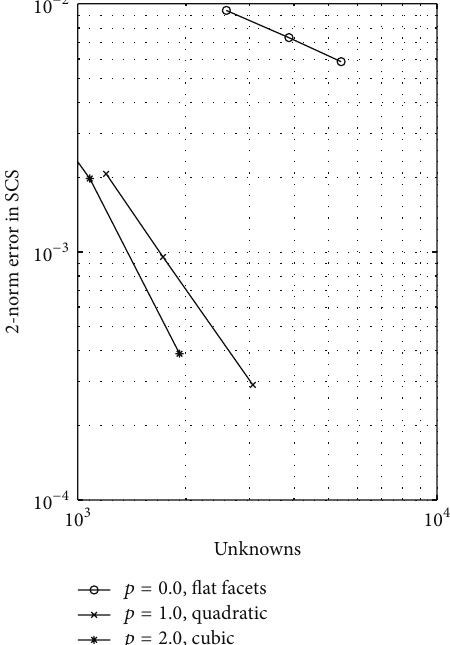
Figure 5: Error in the SCS versus the average edge lengths in the models, for a sphere with 𝑘𝑎 = 2𝜋 . EFIE results are reported for flat-faceted models used in conjunction with 𝑝 = 0.5 basis and test functions, quadratic-curved models used with 𝑝 = 1.5 functions, and cubic-curved models used with 𝑝 = 2.5 functions. Ideal asymptotic rates of 𝑂(ℎ 3 ) , 𝑂(ℎ 5 ) , and 𝑂(ℎ 7 ) are shown for comparison.